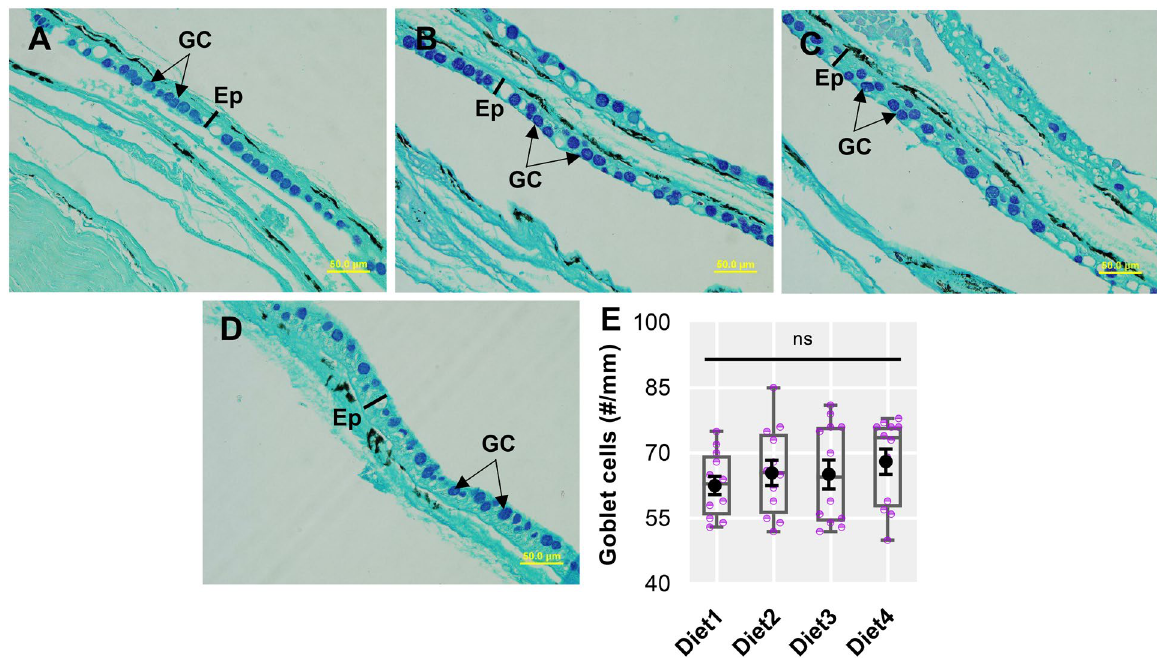
Figure 3. Representative skin micrographs ( A – D , AB-PAS stain, 40 × magnification) and number of mixed goblet cells of barramundi fed Control (Diet1), 80PBM 10TH+10HI (Diet2), 85PBM 5TH+10HI (Diet3), and 90PBM 5TH+5HI (Diet4) for six weeks. Variation in the mixed types of goblet cells in the skin ( E ) of barramundi fed test diets. Multiple comparisons were performed by one-way ANOVA analysis followed by Dunnett’s multiple comparisons test. ns denotes not significant. GC, goblet cell and Ep, epidermis.